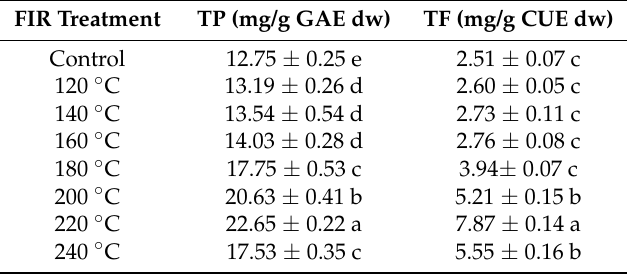
Table 1. Total phenolic (TP) and total flavonoid (TF) content of Angelica gigas Nakai treated by FIR irradiation.